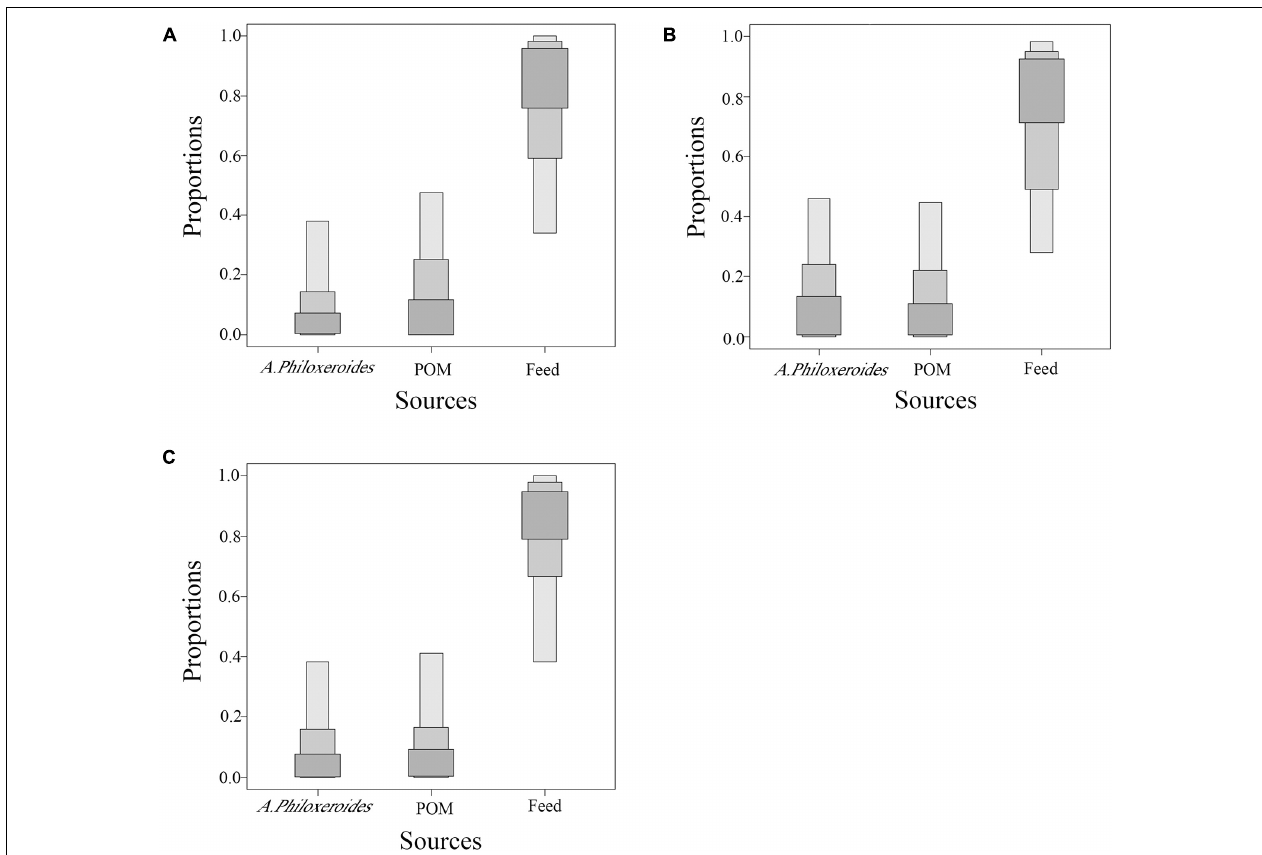
FIGURE 6 | Feed contribution rate of juvenile Eriocheir sinensis based on the stable isotope analysis in R package (SIAR) analysis. (A) Traditional feeding mode, (B) Formulated feeding mode, and (C) Mixture feeding mode.